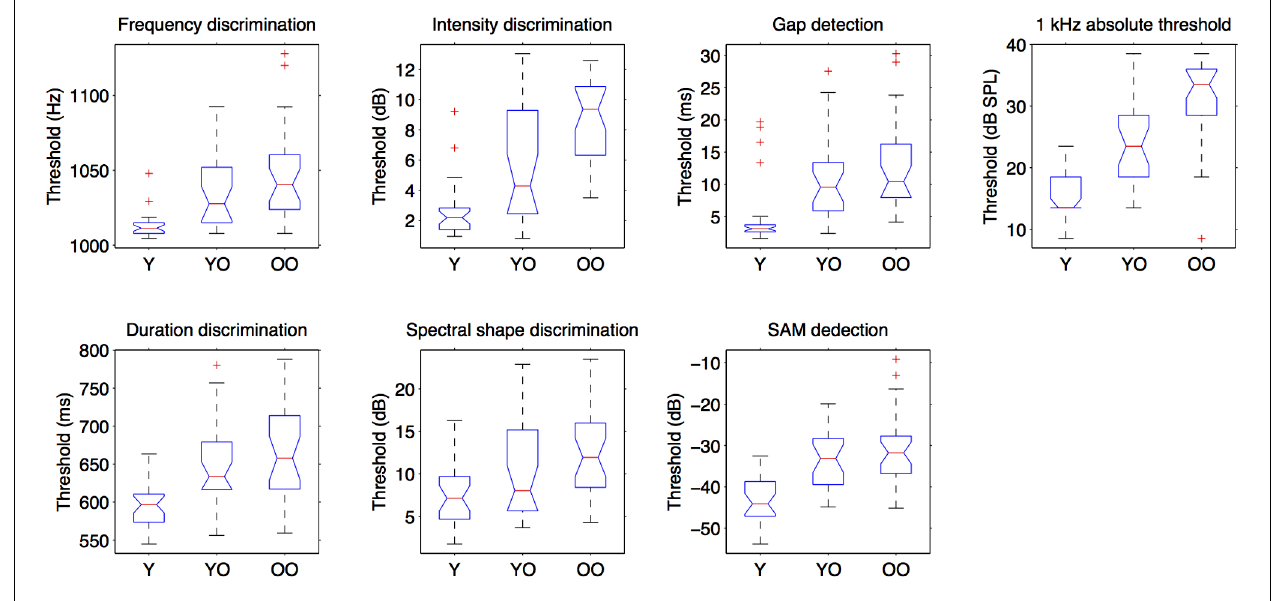
FIGURE 2 | Performance of the three age-groups in the auditory tasks . “Y” are young participants (age < 35), “YO” are young–old participants (65 ≤ age ≤ 75) and “OO” are old–old participants (age > 75).